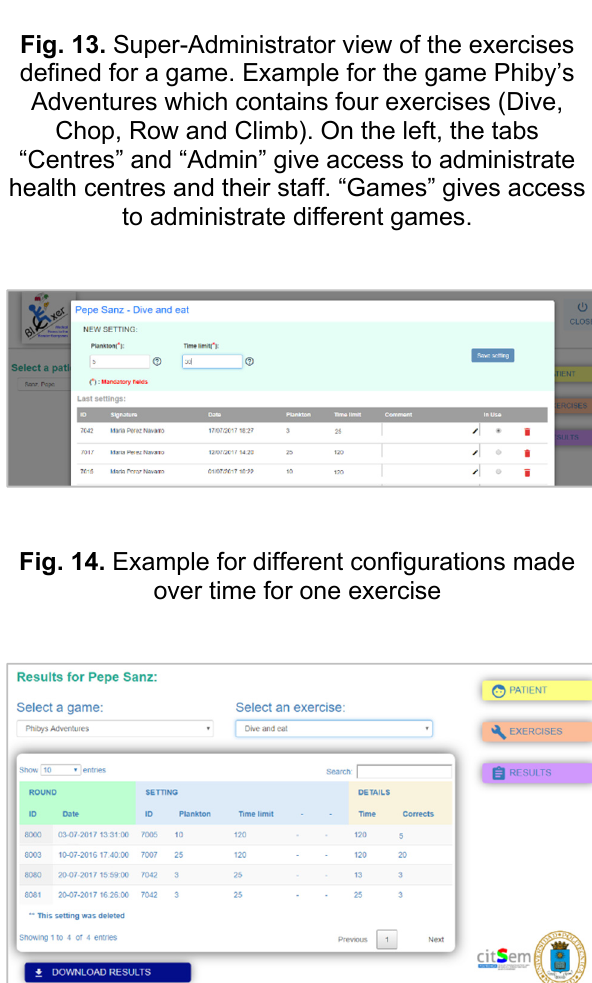
Fig. 16. Exchange of configuration information